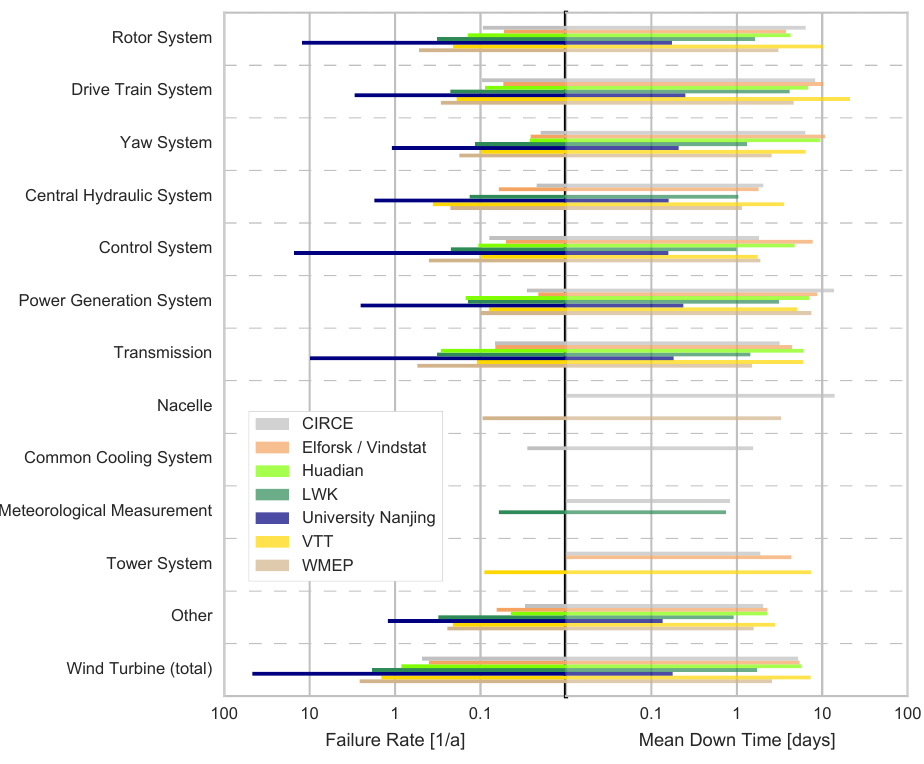
Figure 6. Overview on failure rate and mean down time per WT as published by different